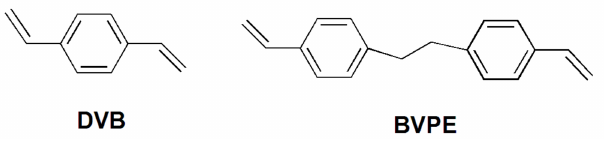
Figure 1. Structures of DVB and